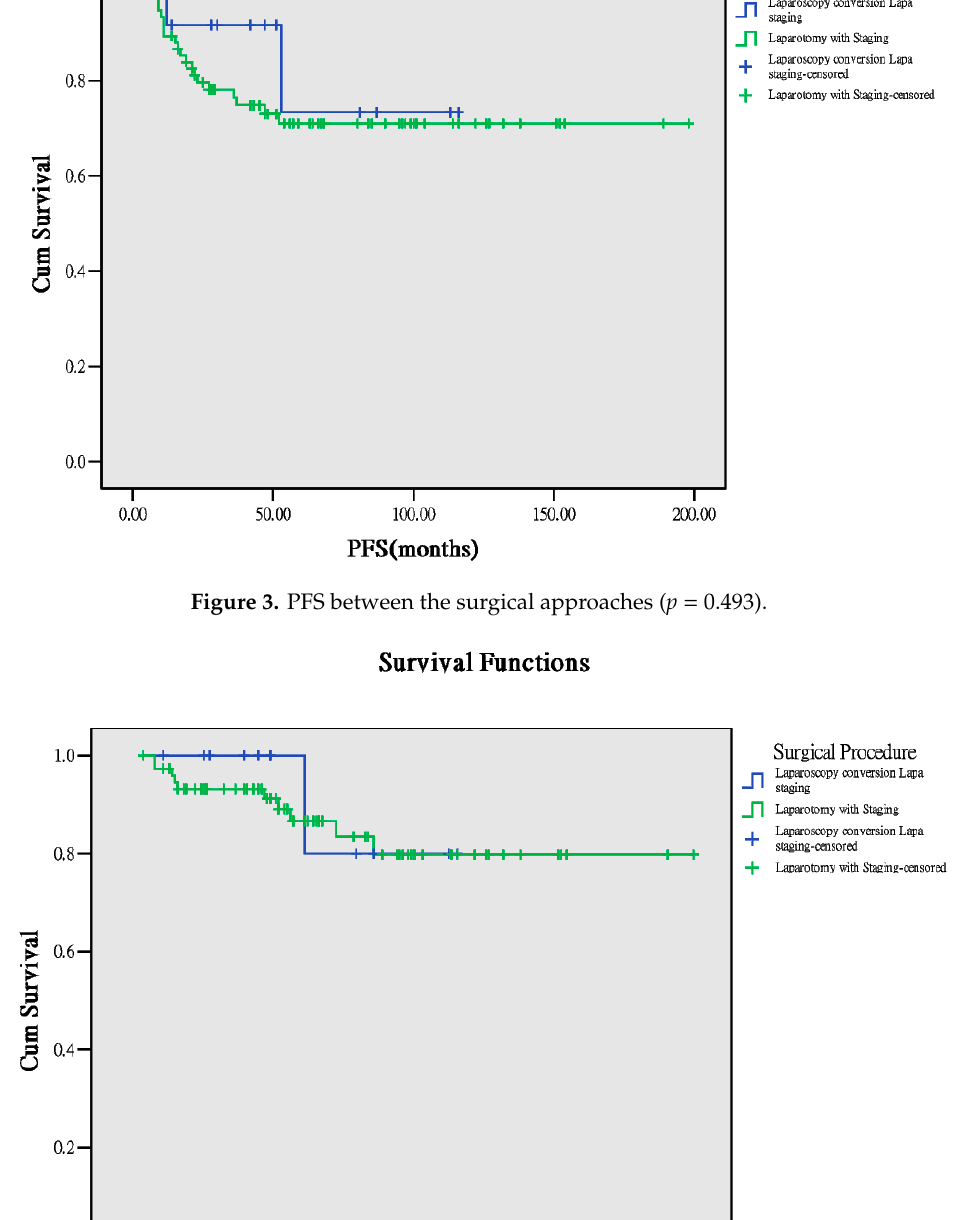
Figure 4. OS between the surgical approaches ( p = 0.709).